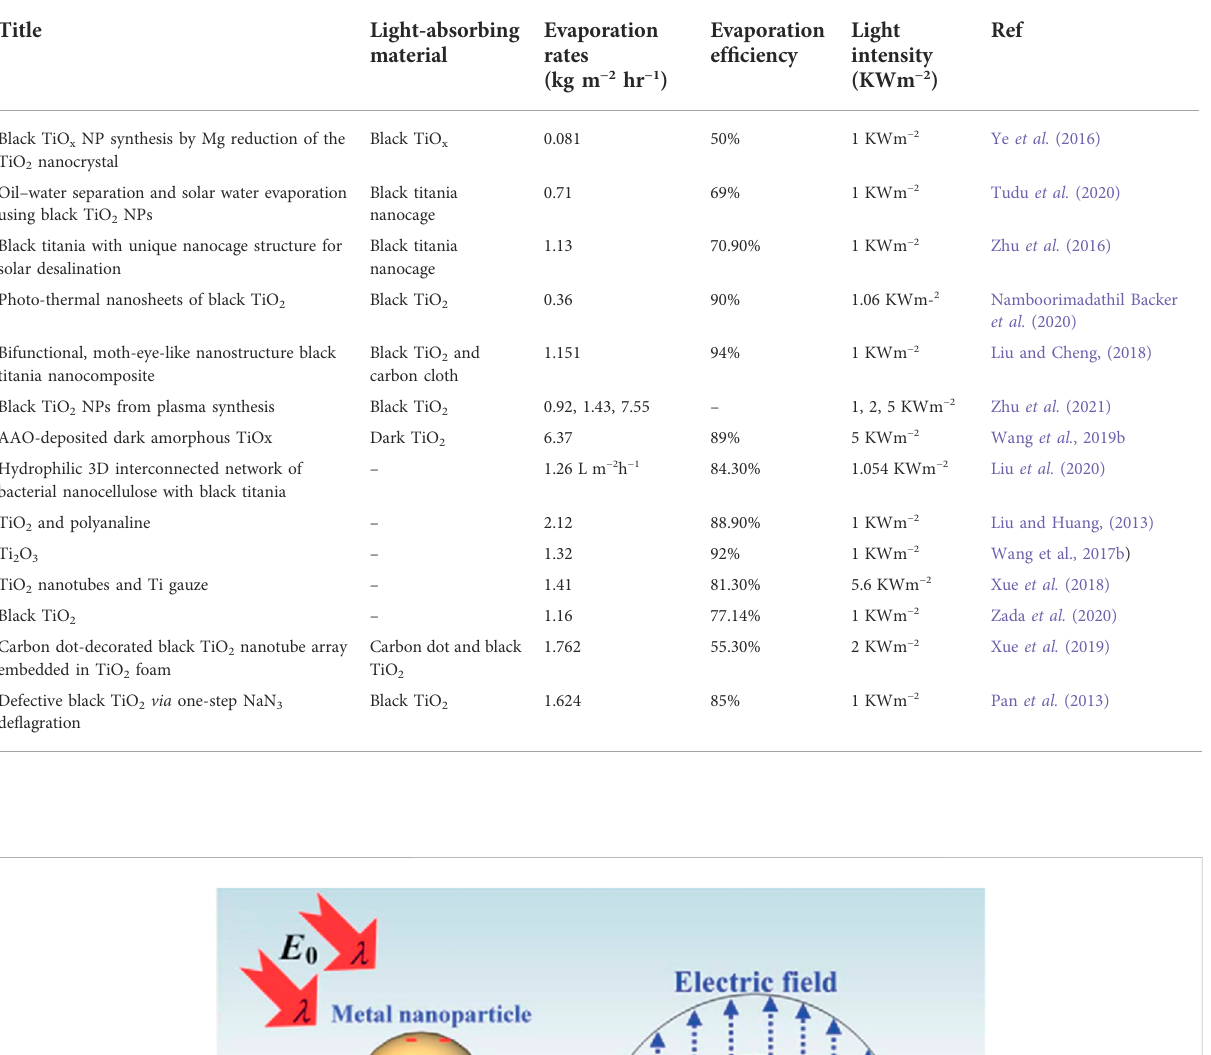
TABLE 1 Different TiO 2 and black/reduced TiO 2 materials with their solar evaporation and ef fi ciency rates.